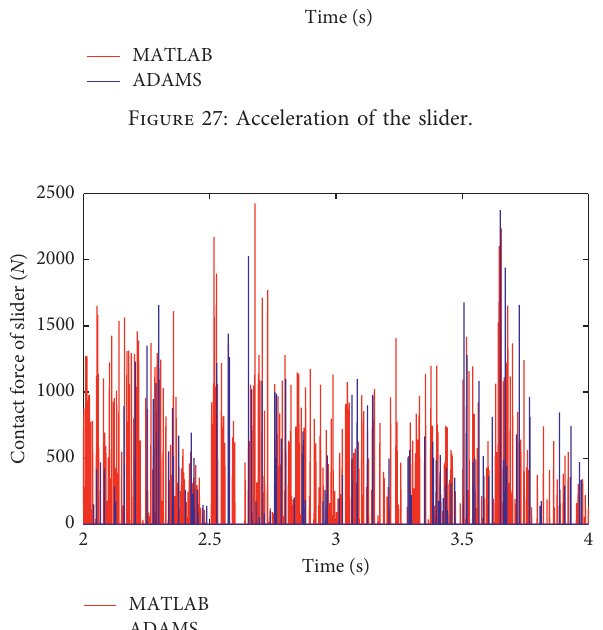
Figure 28: Contact force of the